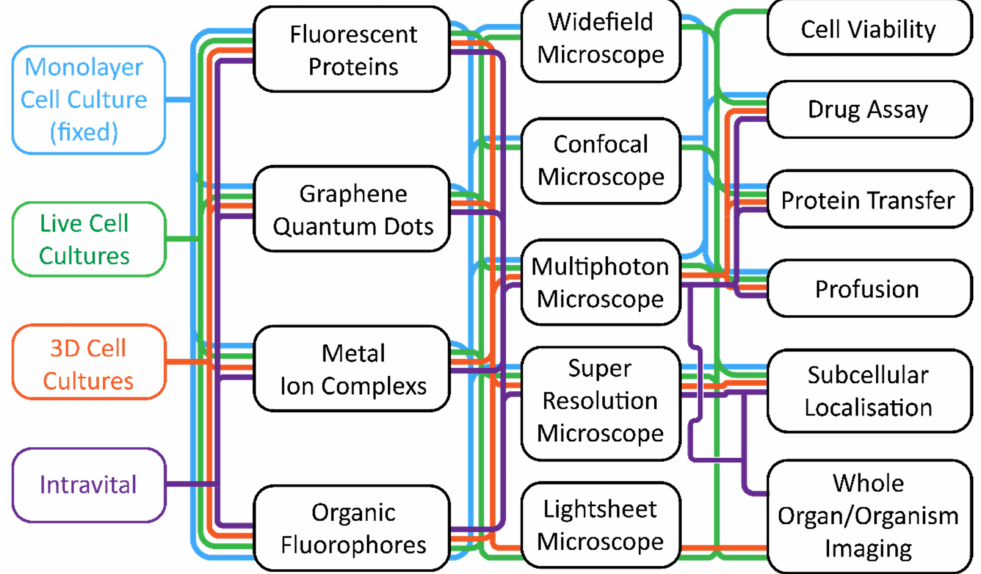
Figure 1. A flowchart linking biological systems to hardware combinations and applications. This flowchart should be read either from left to the right, working from the biological system to the desired application, or from right to left, where the application is chosen first. The flowchart is colour coordinated, and a chosen biological system will use the same colour throughout (blue for monolayer cell cultures, green for live cell cultures, orange for 3D cell cultures, and purple for intravital